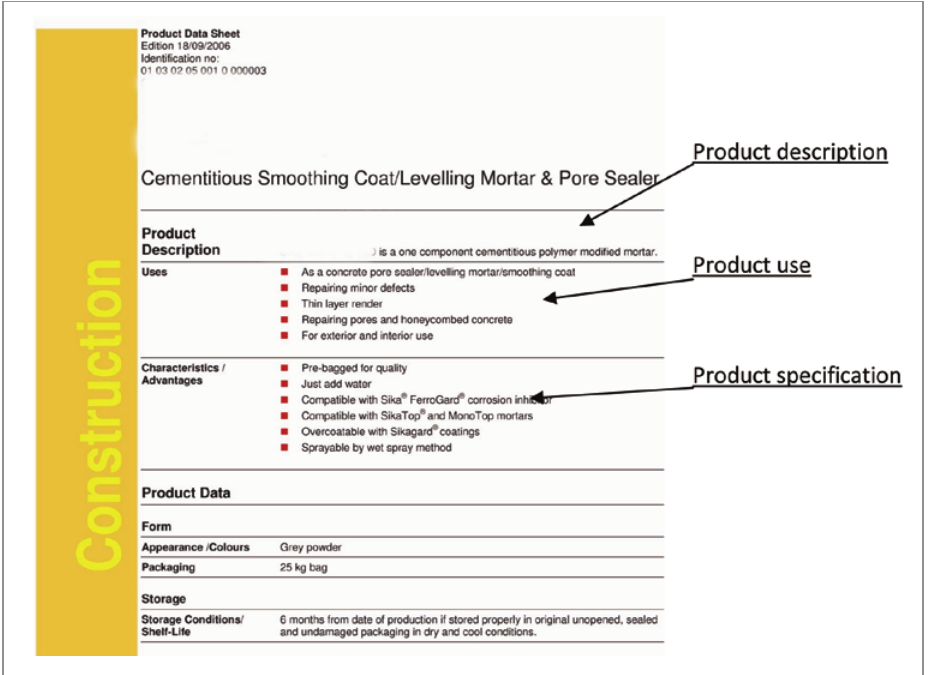
Fig. 5. Frame of text document – technologic sheet of